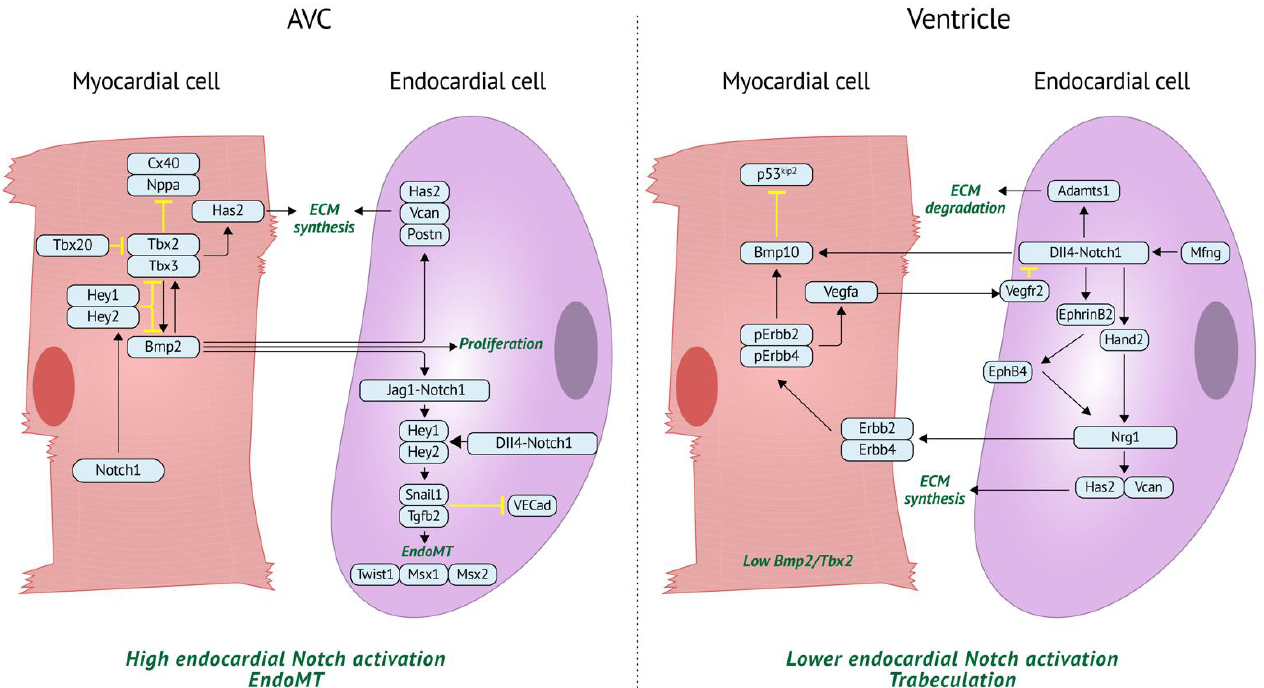
Figure 3. The same signaling pathway (Notch) can produce different effects based on location during early development (E9–E14 in mouse). In the AVC, myocardial cells have high BMP2/TBX2 levels. This represses expression of chamber markers ( Nppa / Cx40 ) and leads to high activation of the Notch pathway in endocardial cells, resulting in EndoMT, ECM cardiac jelly deposition, and cushion formation. By contrast, Bmp2 / Tbx2 is lowly expressed in ventricular chamber myocardium and Notch activation in endocardial cells is lower; thus, EndoMT does not occur. Instead, Notch activates Nrg1 via EphrinB2 and Hand2 to induce trabeculation and expression of Bmp10 in myocardium. A correct balance between Nrg1 -regulated ECM synthesis and Notch1 -regulated ECM degradation is necessary for normal trabeculation to occur. Vcan : Versican, Postn : Periostin, VECad: VE cadherin, Mfng: Manic fringe, Nrg1 : Neuregulin.